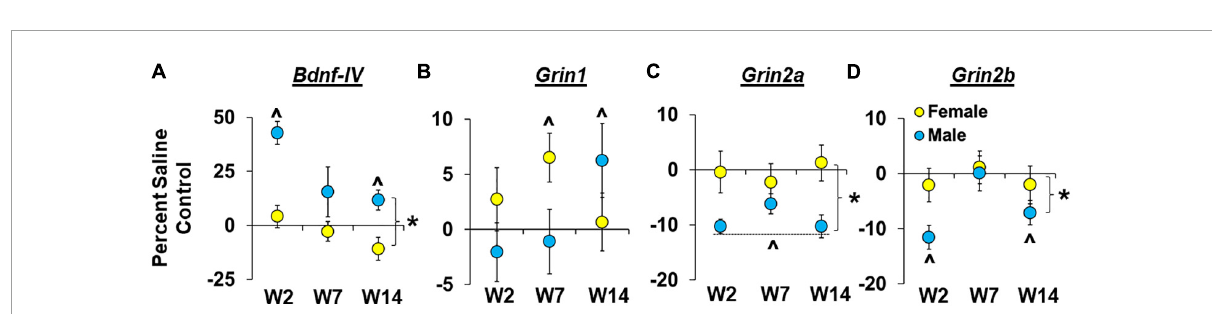
FIGURE5 Sex- and withdrawal-specific changes in Bdnf-IV , Grin1 , Grin2a , and Grin2b expression in the dorsomedial prefrontal cortex (dmPFC). Mean ( ± SEM) percent difference from saline controls for Bdnf-IV (A) , Grin1 (B) , Grin2a (C) , Grin2b (D) in the dmPFC for males and females in the early (W2; n = 13 females, 10 males), intermediate (W7; n = 13 females, 10 males), and late (W14; n = 13 females, 10 males) withdrawal groups. *Significant difference between females and males. ˆSignificant difference from zero in females and